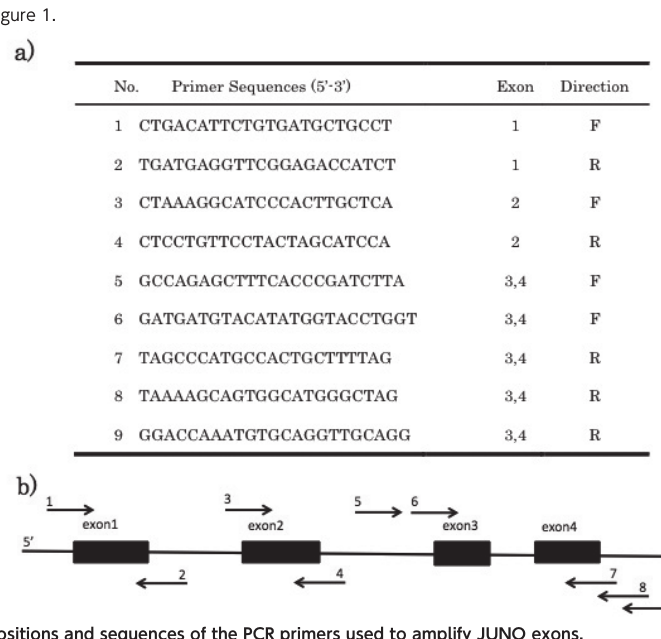
Positions and sequences of the PCR primers used to amplify JUNO exons. a) The sequences of primers used for PCR are shown. b) The exon-intron organization of JUNO is shown. Black boxes indicate exons. Positions and directions of the primers are depicted by arrows.